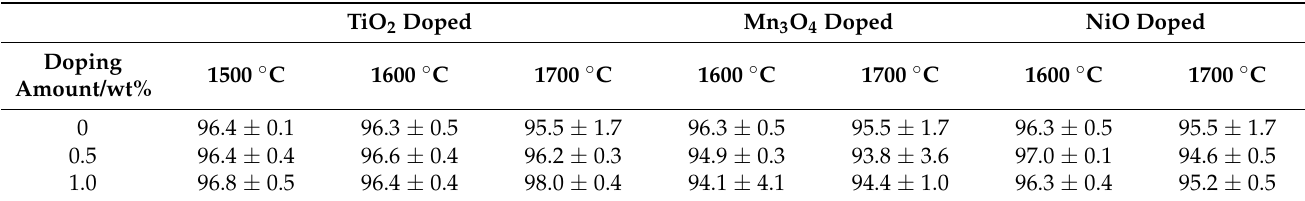
Figure 2. Diffraction patterns of undoped Na- β″ -alumina sintered at 1500 °C, 1600 °C, or 1700 °C. The literature reflexes of Na- β″ -alumina (pdf 84-1715) are illustrated by the red bars at the bottom. The reflex 006 (15.8°) is clipped off. Table 1. Na- β (cid:48)(cid:48) -alumina phase content [wt%] of differently sintered and doped